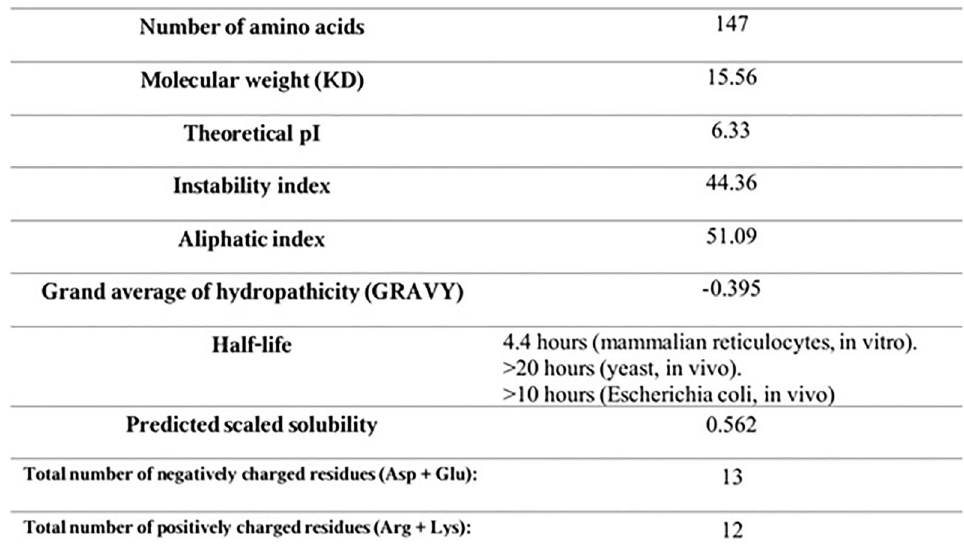
Figure 4. Physico-chemicalparameters evaluation by ProtParam server.